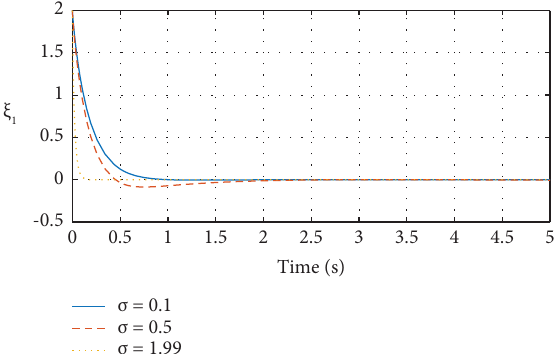
− ξ plane for Example 2 with control. 1 2